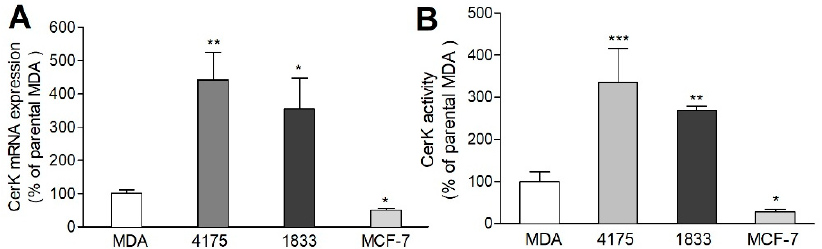
Figure 1. Ceramide kinase (CerK) mRNA expression and activity in parental and metastatic MDA-MB-231 cells and in MCF-7 cells. ( A ) Confluent cells, either parental MDA-MB-231 (MDA), the lung metastatic subline 4175, or the bone-metastatic subline 1833, and MCF-7 were taken for RNA extraction and quantitative PCR analysis of CerK and 18S RNA. ( B ) Confluent cells were incubated for 3 h with 5 µ M of C6-NBD-ceramide. Lipids were then extracted, separated by TLC, and analyzed as described in the Methods section. Results are expressed as percentage of parental MDA-MB-231 cells and are means ± SD ( n = 4), * p < 0.05, ** p < 0.01, *** p < 0.001 considered statistically significant compared to the parental MDA-MB-231 values.